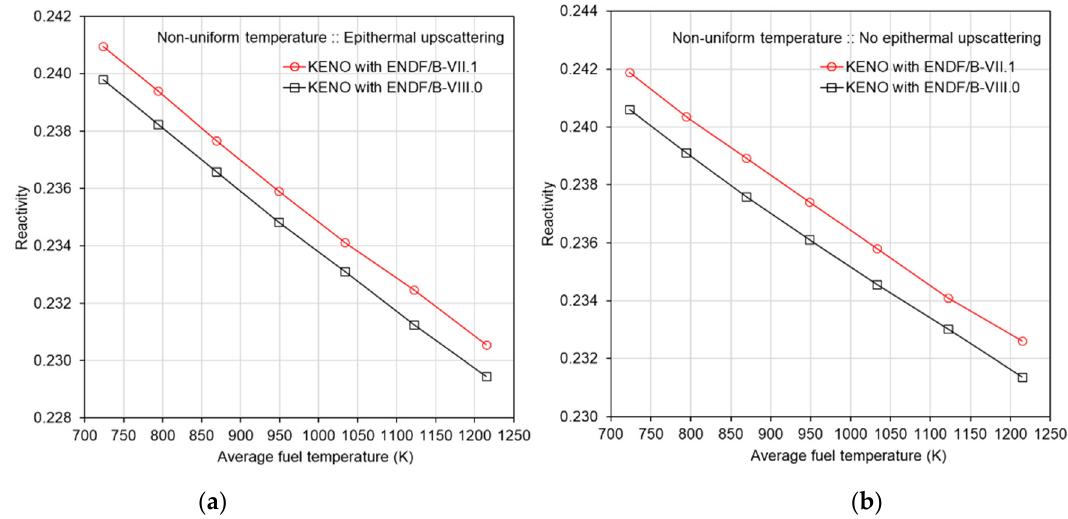
Figure 5. Comparison of reactivities with nonuniform fuel temperature distribution: ( a ) epithermal upscattering; ( b ) no epithermal upscattering.